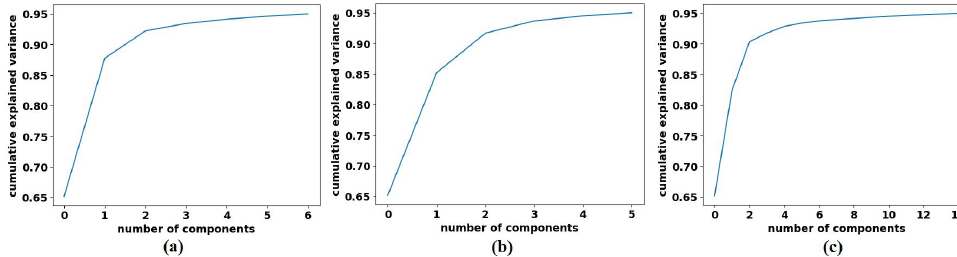
Figure 7. The explained variance of the principal components for each class in the Brain tumour dataset: ( a ) glioma, ( b ) meningioma, ( c ) pituitary